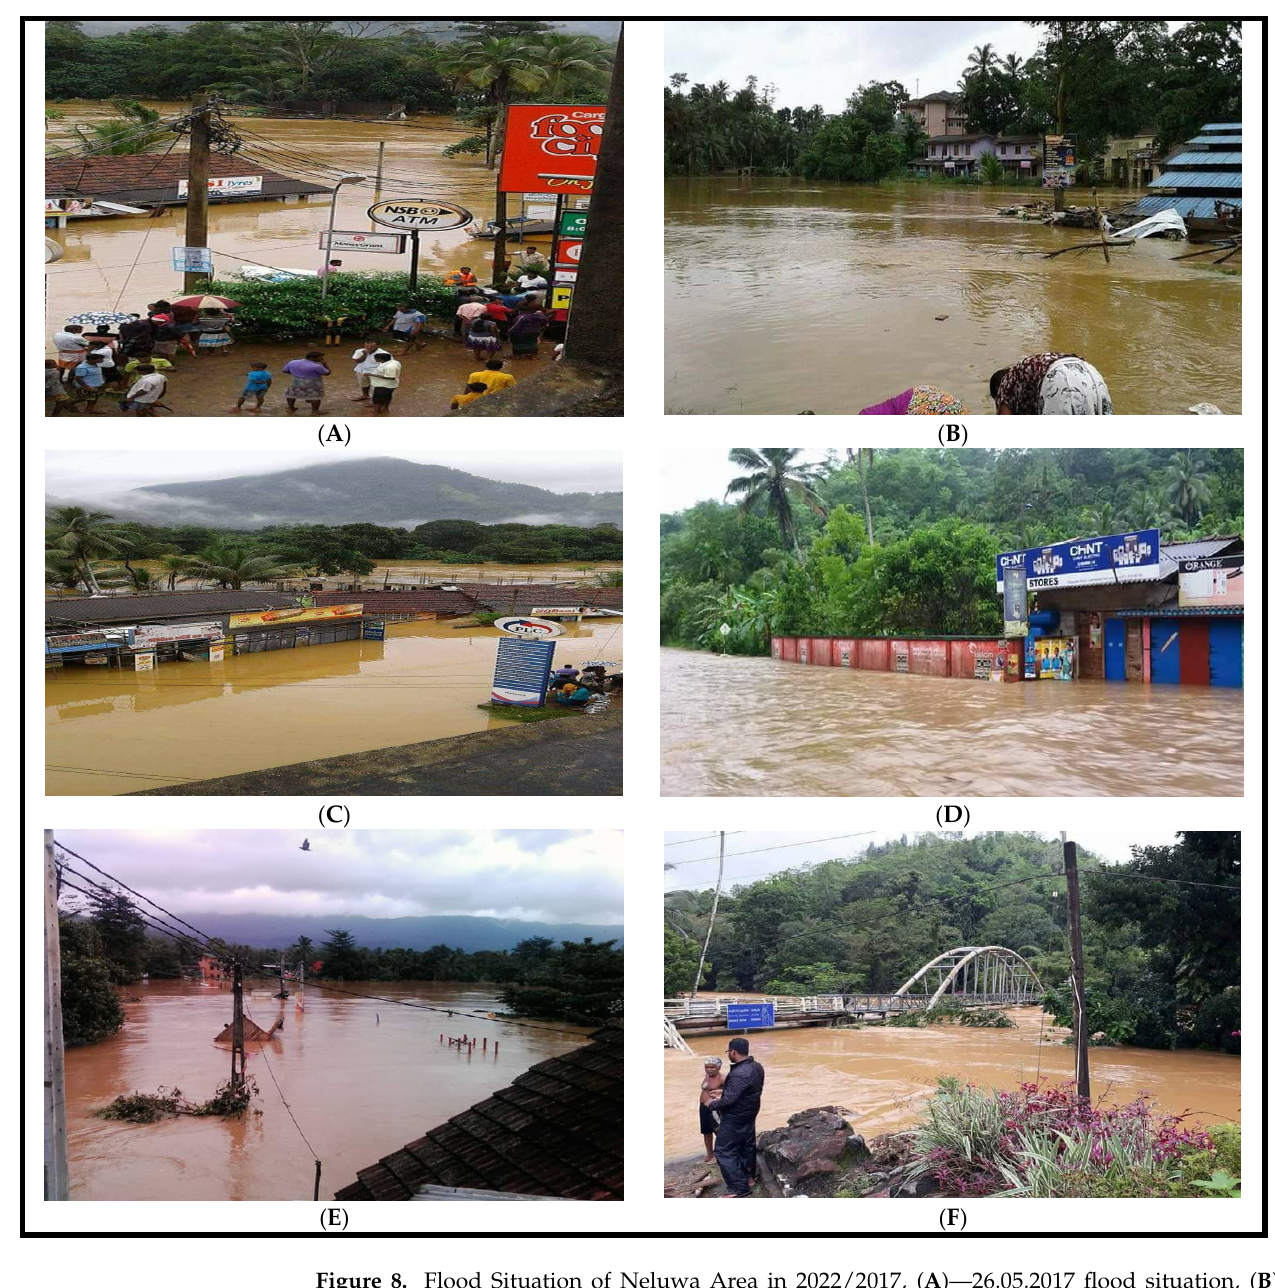
Figure 8. Flood Situation of Neluwa Area in 2022/2017, ( A )—26.05.2017 flood situation, ( B )— 26.05.2017 flood situation, ( C )—26.05.2017 flood situation, ( D )—27.05.2022 flood situation, ( E )— 27.05.2022 flood situation, ( F )—27.05.2022 flood situation.